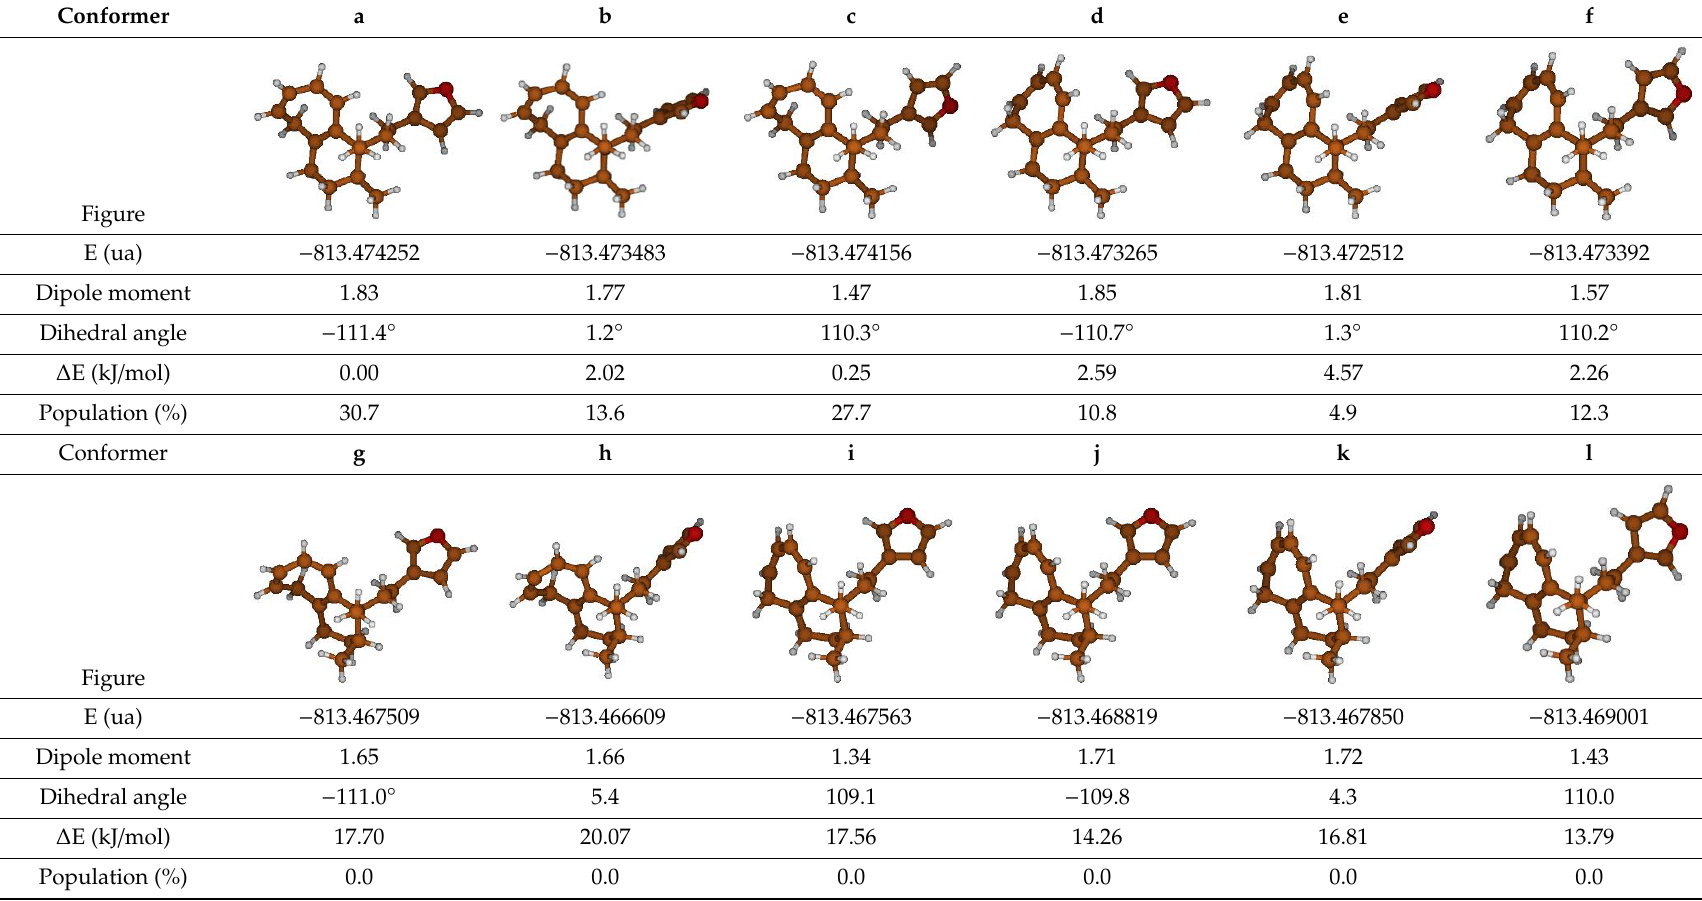
Table 3. Calculated B3LYP / 6-311 + G(d,p) Energies a , Dipole moments (Debye), relatives Energies a , (C13-C14-C15-C18) dihedral angle, Equilibrium population at 25 ◦ C Table 3. Calculated B3LYP/6-311+G(d,p) Energies a , Dipole moments (Debye), relatives Energies a , (C13-C14-C15-C18) dihedral angle, Equilibrium population at Table 3. Calculated B3LYP/6-311+G(d,p) Energies a , Dipole moments (Debye), relatives Energies a , (C13-C14-C15-C18) dihedral angle, Equilibrium population at Table 3. Calculated B3LYP/6-311+G(d,p) Energies a , Dipole moments (Debye), relatives Energies a , (C13-C14-C15-C18) dihedral angle, Equilibrium population at Table 3. Calculated B3LYP/6-311+G(d,p) Energies a , Dipole moments (Debye), relatives Energies a , (C13-C14-C15-C18) dihedral angle, Equilibrium population at Table 3. Calculated B3LYP/6-311+G(d,p) Energies a , Dipole moments (Debye), relatives Energies a , (C13-C14-C15-C18) dihedral angle, Equilibrium population at and figures of conformations a-l of the 8 R , 9 S isomer of dodovisate C ( 1 ). Table 3. Calculated B3LYP/6-311+G(d,p) Energies a , Dipole moments (Debye), relatives Energies a , (C13-C14-C15-C18) dihedral angle, Equilibrium population at Table 3. Calculated B3LYP/6-311+G(d,p) Energies a , Dipole moments (Debye), relatives Energies a , (C13-C14-C15-C18) dihedral angle, Equilibrium population at 25°C and figures of conformations a-l of the 8 R , 9 S isomer of dodovisate C ( 1 ). 25°C and figures of conformations a-l of the 8 R , 9 S isomer of dodovisate C ( 1 ). 25°C and figures of conformations a-l of the 8 R , 9 S isomer of dodovisate C ( 1 ). Table 3. Calculated B3LYP/6-311+G(d,p) Energies a , Dipole moments (Debye), relatives Energies a , (C13-C14-C15-C18) dihedral angle, Equilibrium population at Table 3. Calculated B3LYP/6-311+G(d,p) Energies a , Dipole moments (Debye), relatives Energies a , (C13-C14-C15-C18) dihedral angle, Equilibrium population at 25°C and figures of conformations a-l of the 8 R , 9 S isomer of dodovisate C ( 1 ). 25°C and figures of conformations a-l of the 8 R , 9 S isomer of dodovisate C ( 1 ). 25°C and figures of conformations a-l of the 8 R , 9 S isomer of dodovisate C ( 1 ). Table 3. Calculated B3LYP/6-311+G(d,p) Energies a , Dipole moments (Debye), relatives Energies a , (C13-C14-C15-C18) dihedral angle, Equilibrium population at 25°C and figures of conformations a-l of the 8 R , 9 S isomer of dodovisate C ( 1 Table 3. Calculated B3LYP/6-311+G(d,p) Energies a , Dipole moments (Debye), relatives Energies a , (C13-C14-C15-C18) dihedral angle, Equilibrium population at 25°C and figures of conformations a-l of the 8 R , 9 S isomer of dodovisate C ( 1 ). 25°C and figures of conformations a-l of the 8 R , 9 S isomer of dodovisate C ( 1 ). Conformer Table 3. Calculated B3LYP/6-311+G(d,p) Energies a , Dipole moments (Debye), relatives Energies a , (C13-C14-C15-C18) dihedral angle, Equilibrium population at 25°C and figures of conformations a-l of the 8 R , 9 S isomer of dodovisate C ( 1 ). 25°C and figures of conformations a-l of the 8 R , 9 S isomer of dodovisate C ( 1 ). Conformer 25°C and figures of conformations a-l of the 8 R , 9 S isomer of dodovisate C ( 1 ).